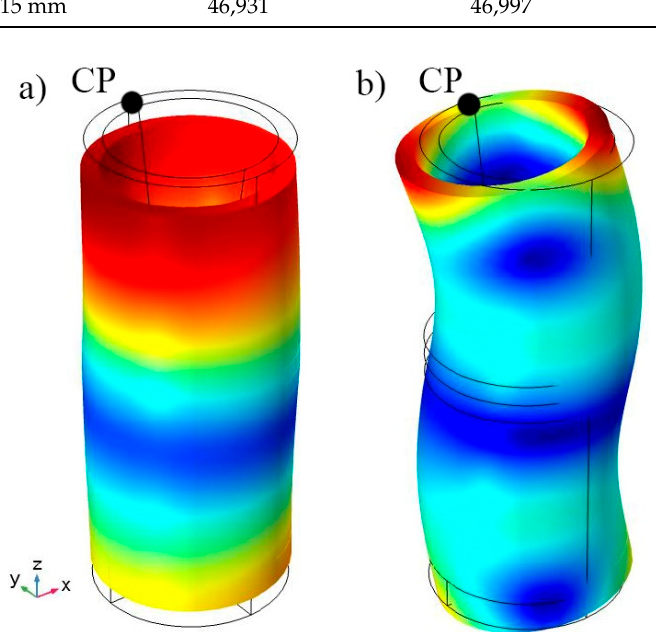
Figure 3. The vibration modes of the waveguide; a) the first longitudinal vibration mode at 51,202 Hz; b) the second bending vibration mode at 51,245 Hz ; CP, contact point.